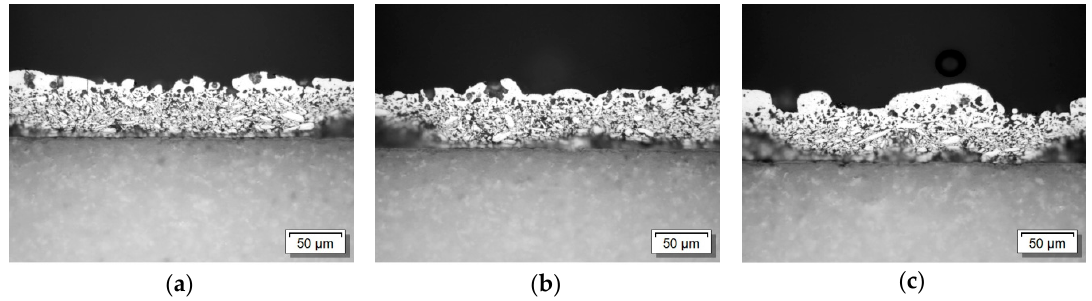
Figure 7. Cross section of laser treated specimen: ( a ) E sq. = 0.088 J/mm²; ( b ) E sq. = 0.154 J/mm²; ( c ) E sq. = 0.206 J/mm².